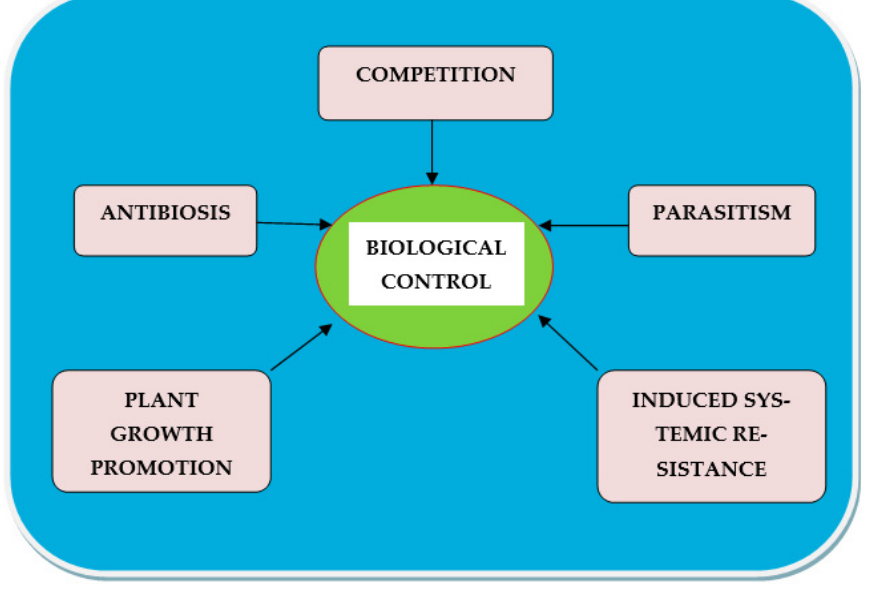
Figure 1. An overview of different mechanisms of